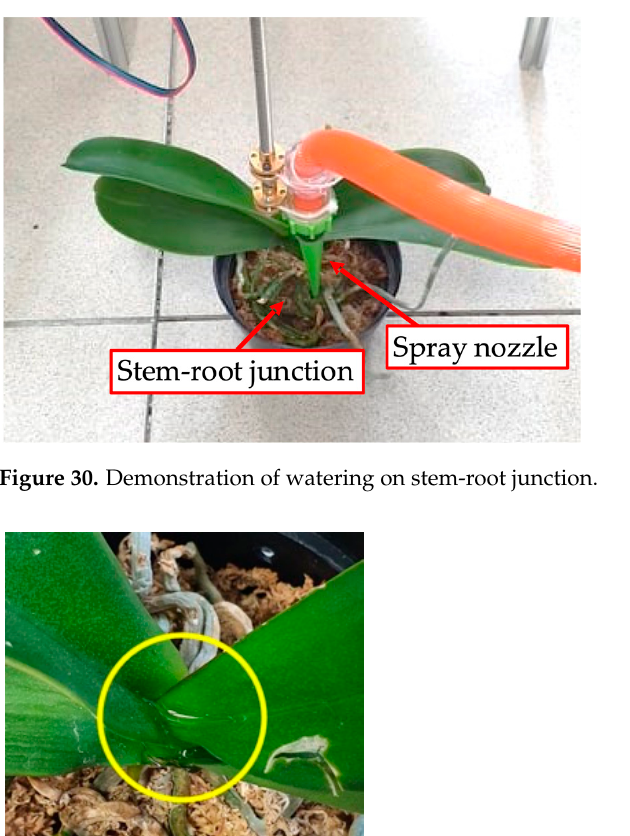
Table 2. Experimental results of automatic irrigation experiments with the same plant but differ- ent position of seedling.